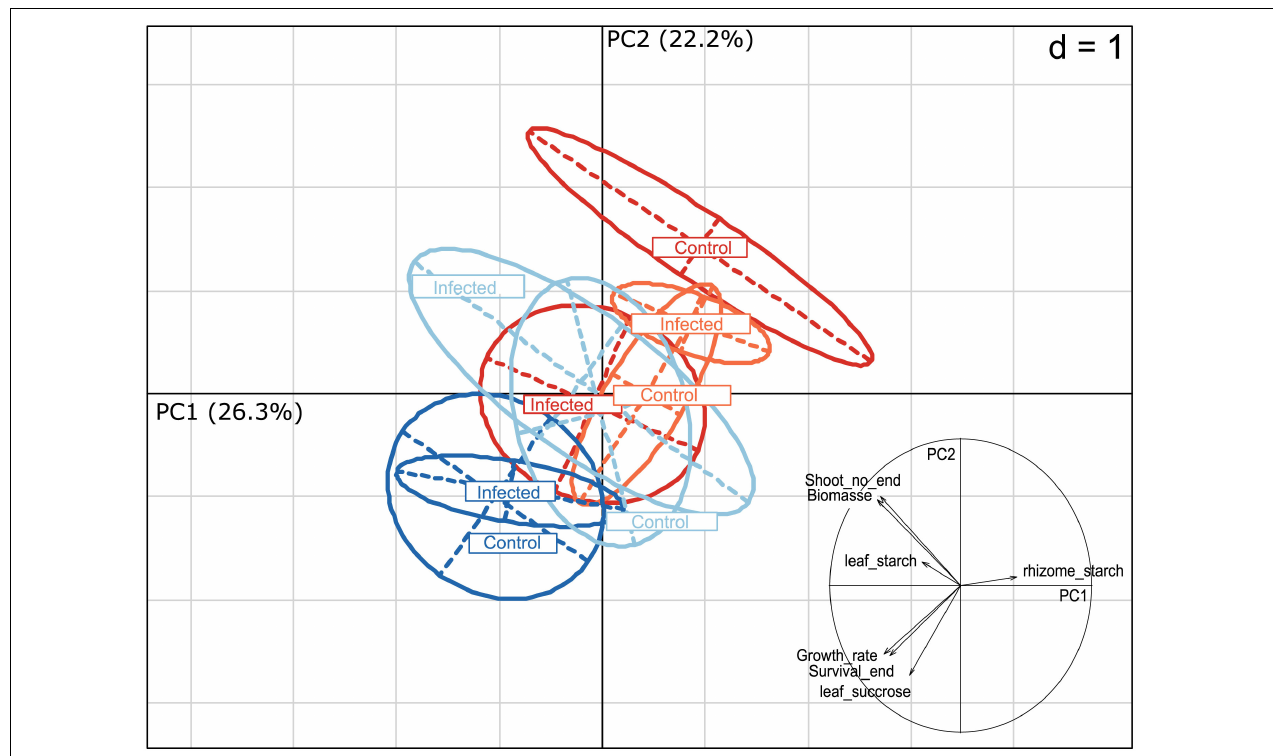
FIGURE 6 | Principal component analysis (PCA) of eelgrass responses (leaf growth rate, shoot production, survival rate, rhizome starch concentration, leaf starch concentration, leaf sucrose concentration, plant dry weight) as a function of the multi-stressor treatments. Vectors within the circle indicate the direction and strength of particular variables to the overall response in an indicator variable analysis. Treatments were pooled over salinity levels as no significant effect or interaction of salinity was detected by PERMANOVA ( Table 3 ), dark red, heat stressed and full light; light red, heat stressed and shaded; dark blue, ambient temperature and full light; light blue, ambient temperature and